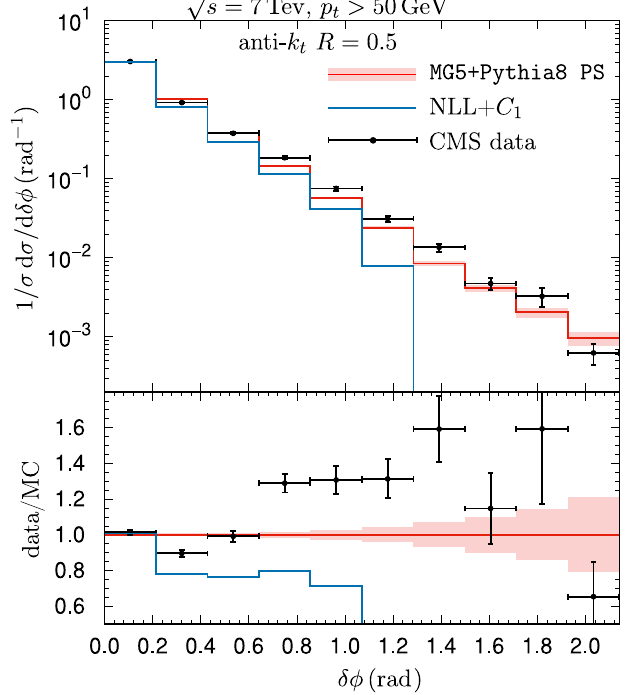
Figure 8 . Comparison between the NLL-resummed distribution, the Pythia 8 parton shower result (including Z + 2 jet process), and the CMS